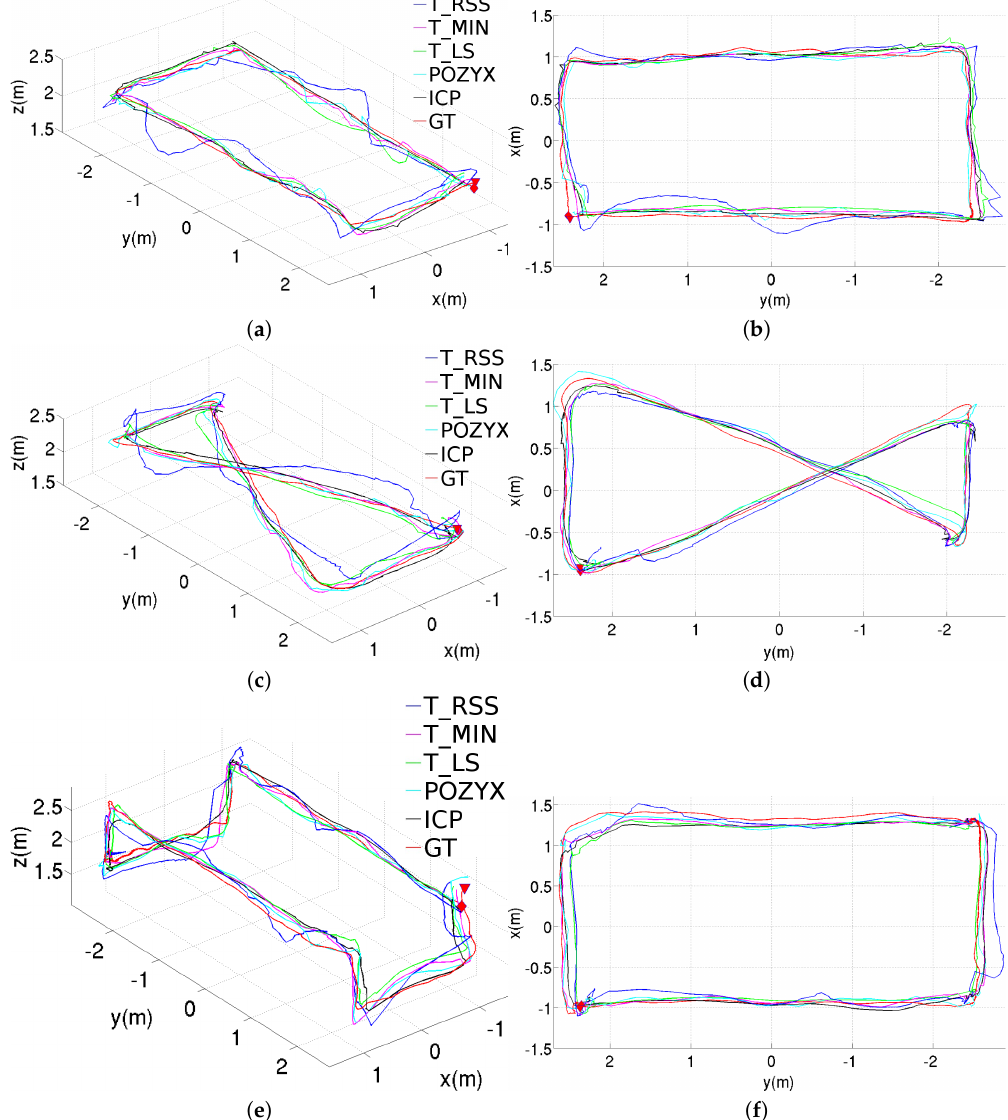
Figure 9. Position estimations provided by the different methods for the three trajectories performed inside the laboratory, results obtained using both the pre- and post-filtering stages: ( a ) perspective and ( b ) top views for the rectangular trajectory; ( c ) perspective and ( d ) top views for the figure-eight-like trajectory; ( e ) perspective and ( f ) top views for the rectangular trajectory with changes in